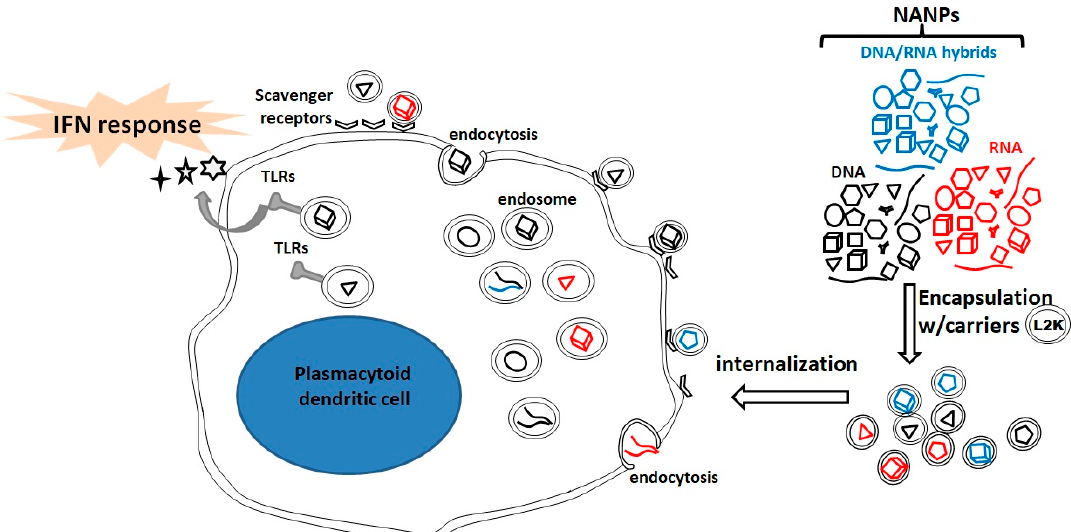
Figure 5. Immune response induction activated by NANPs [1]. NANPs complexed with L2K